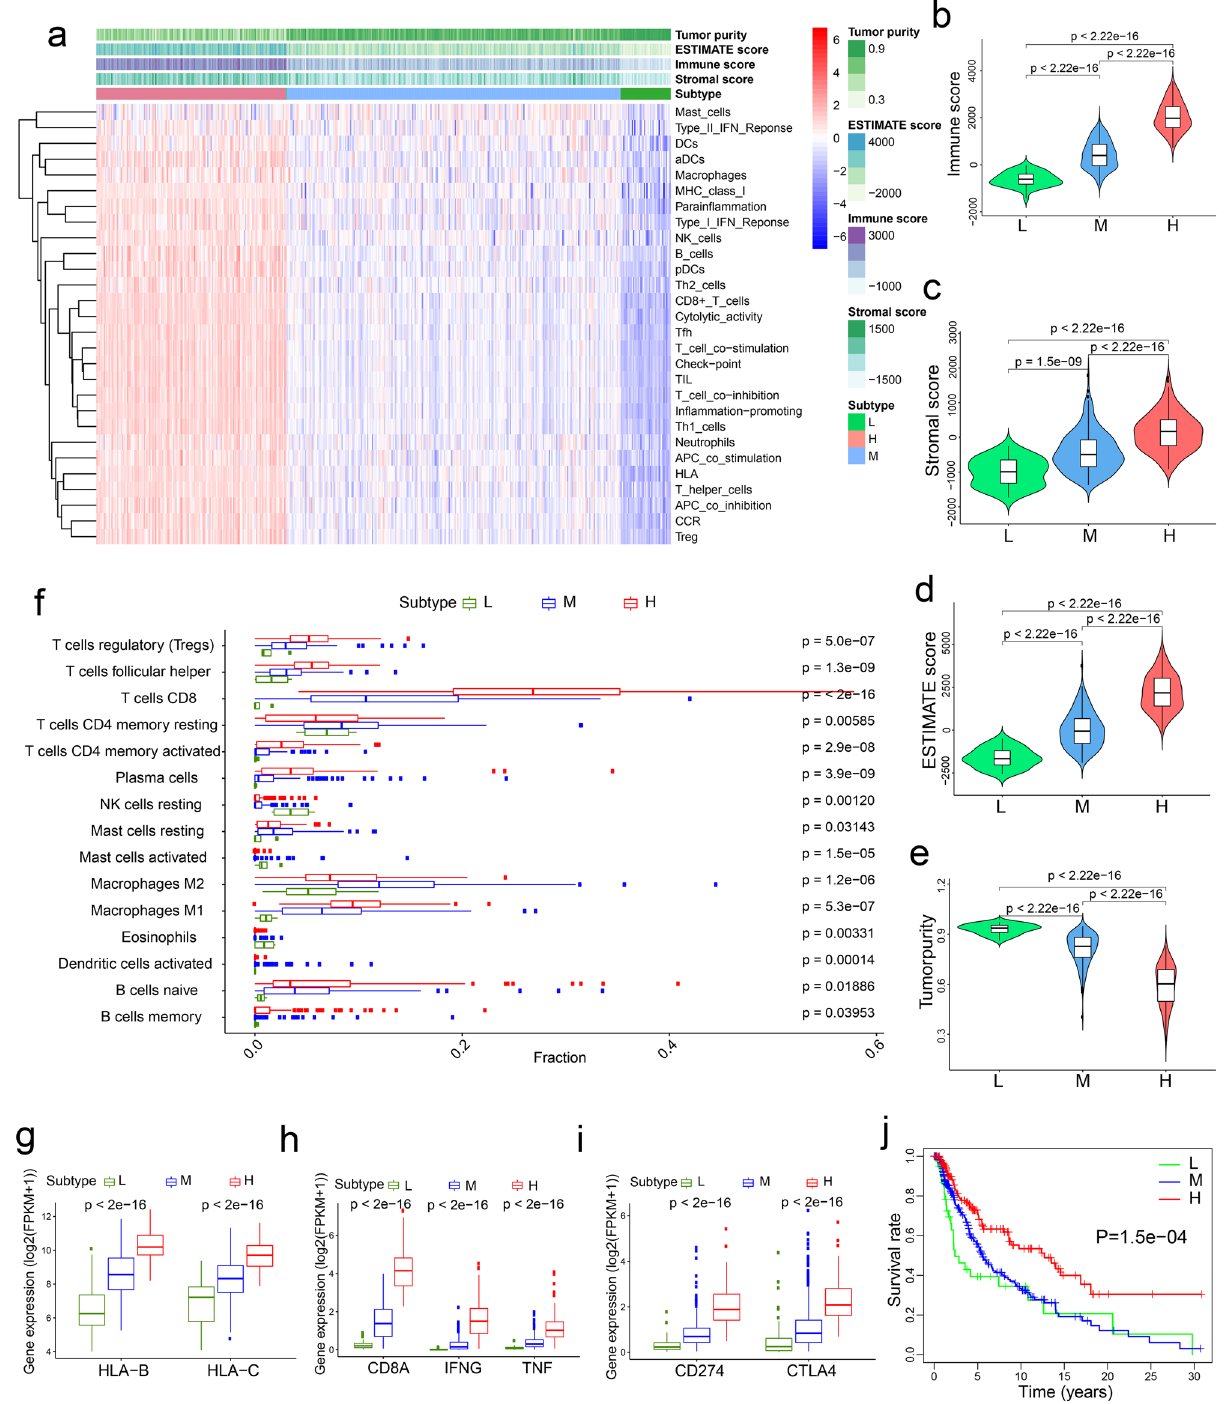
Fig. 1 Classi fi cation of human skin cutaneous melanoma (SKCM) into three immune subtypes. a Hierarchical clustering of TCGA human skin cutaneous melanoma (SKCM) patients ( n = 471) into three immune subtypes: high-immunity (H), n = 156; medium-immunity (M), n = 274; and low-immunity (L), n = 41. The tumor purity, ESTIMATE score, immune score, and stromal score were determined by the ESTIMATE algorithm. b – e Comparison of the immune cell in fi ltration levels (immune score) ( b ), stromal content (stromal score) ( c ), ESTIMATE score ( d ), and tumor purity ( e ) among three immune subtypes of melanoma. f Relative abundances of 15 types of immune cells in three immune subtypes of melanoma. g mRNA levels of MHC-I genes in three immune subtypes of melanoma. h mRNA levels of genes associated with CD8 + T cells in three immune subtypes of melanoma. i mRNA levels of PD-L1 and CTLA4 in three immune subtypes of melanoma. The boxplot in f – i consists of a box and a set of whiskers. The box is drawn from the fi rst quartile (25th percentile) to the third quartile (75th percentile) with a horizontal line drawn in the middle to denote the median. The lowest point is the minimum of the dataset and the highest point is the maximum of the dataset. j Kaplan – Meier curves of the overall survival rates in three immune subtypes of melanoma. Statistical signi fi cance was determined by the Kruskal – Wallis test in a – i and by the log-rank test in j .